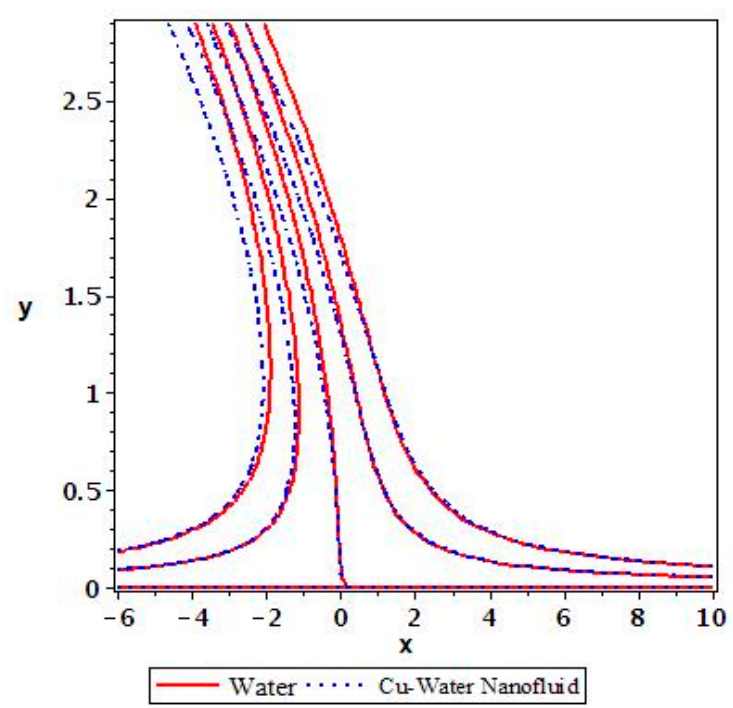
(cid:17) (cid:16) ˆ k nf θ (cid:48) ( 0 ) at the surface against φ . ˆ k f 𝐤(cid:4632) 𝐧𝐟 = − (cid:4672) (cid:4673) 𝛉 (cid:4593) (𝟎) at the surface against 𝛟 . 𝛚 𝐤(cid:4632) 𝐟